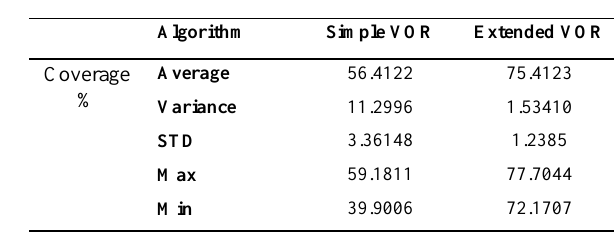
Figure 8. Position of the sensors for both cases in different steps (a) simple VOR algorithm; (b) extended VOR algorithm